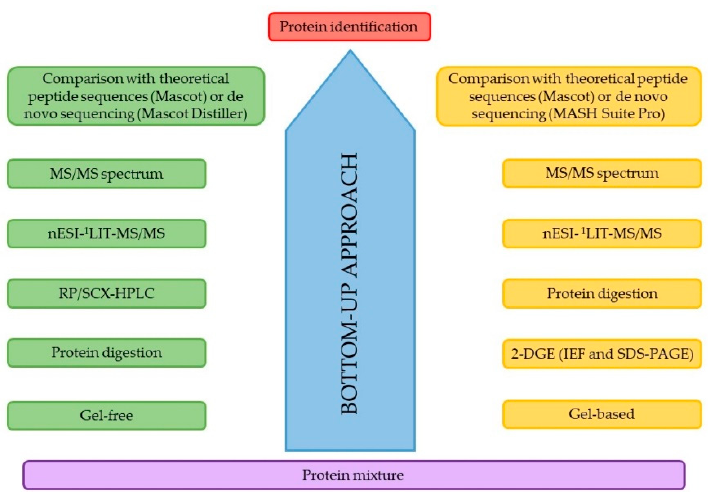
Figure 1. Typical workflow of a proteomic assay following a bottom-up and top-down strategy. 1 LIT: linera ion trap.